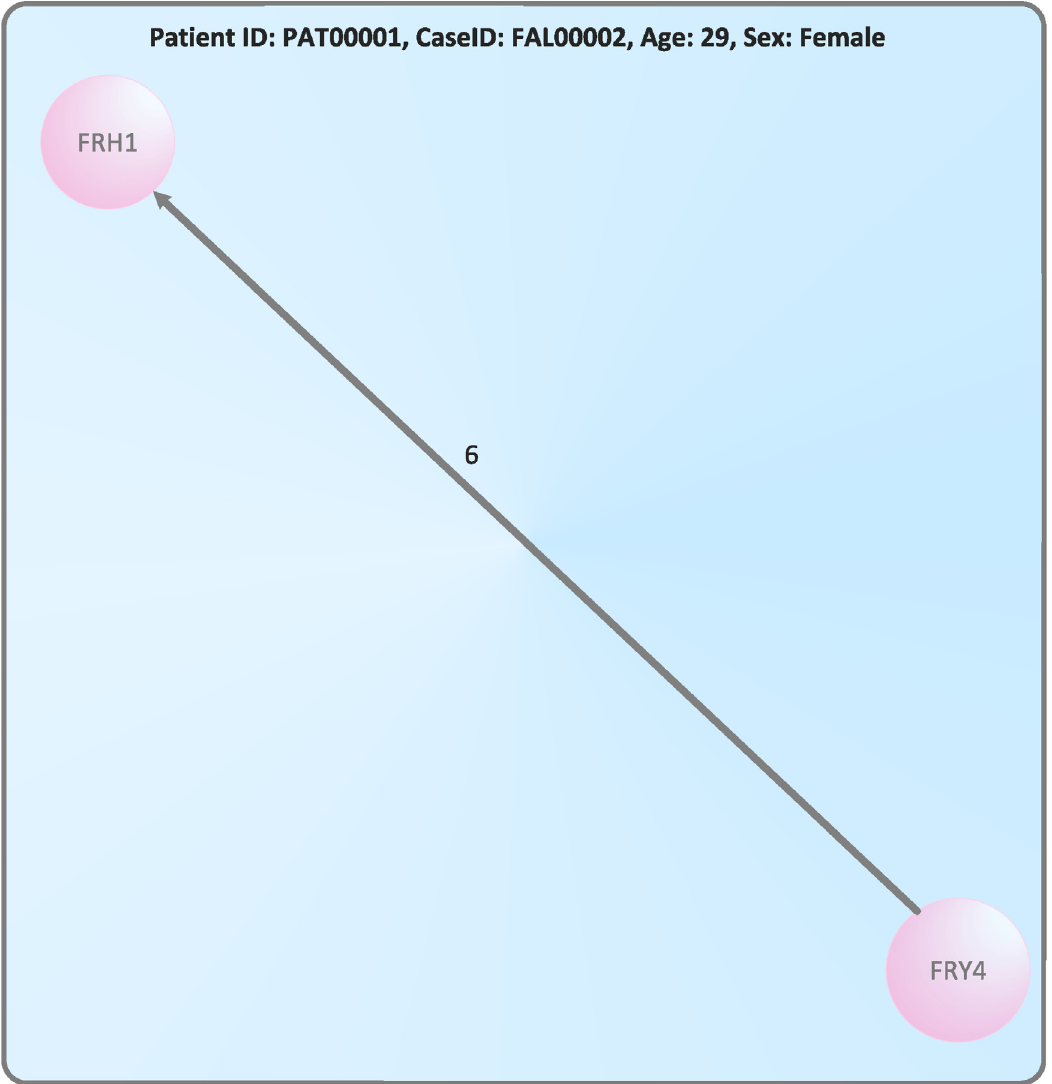
Fig 1. The network G = ( V , E , f E , f V ) for a patient (ID PAT00001) where V = { v 1 , v 2 }, f V ( v 1 ) = FRY4, f V ( v 2 ) = FRH1, T = {FRY4, FRH1}, E = { e 1 }, and f E ( e 1 ) =